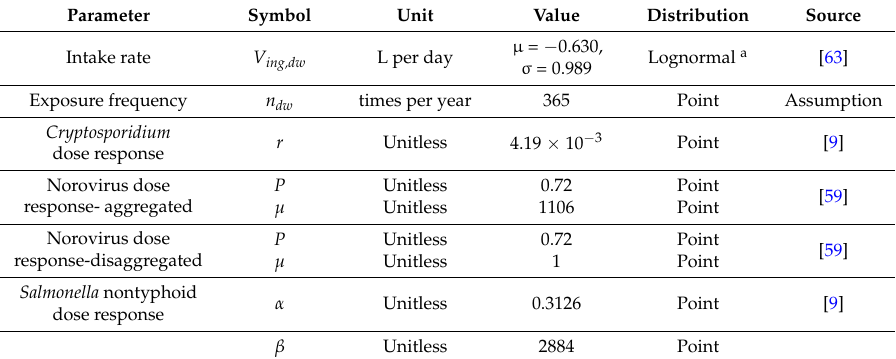
Table 4. Monte Carlo simulation input parameters for exposure and dose